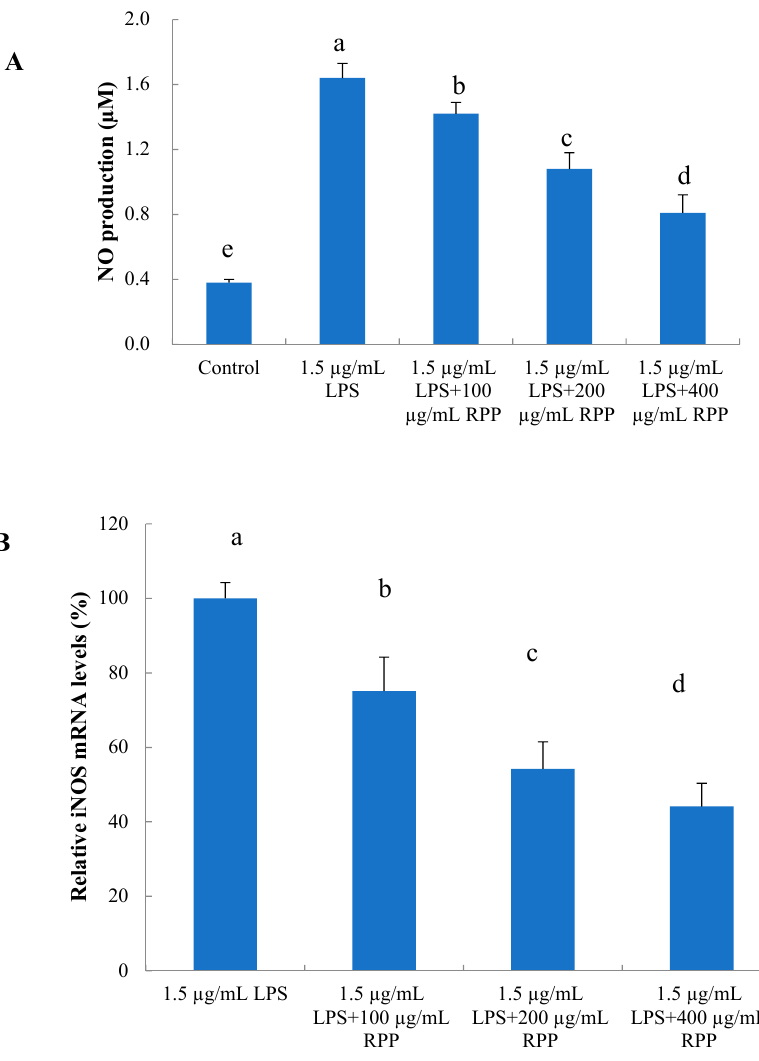
Figure 6. Inhibitory effects of RPP on nitric oxide (NO) production ( A ) and relative inducible nitric oxide synthase (iNOS) mRNA levels ( B ) in lipopolysaccharide (LPS)-stimulated RAW 264.7 cells. Groups with different letters are significantly different ( p < 0.05).